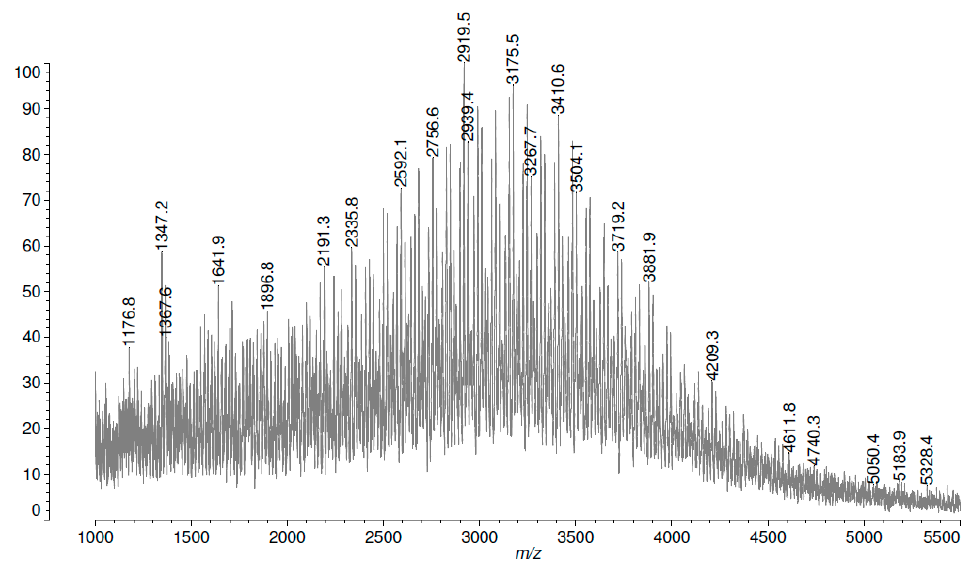
Figure 14. MALDI-TOF spectrum of BO/BGE copolyether-diol (21).